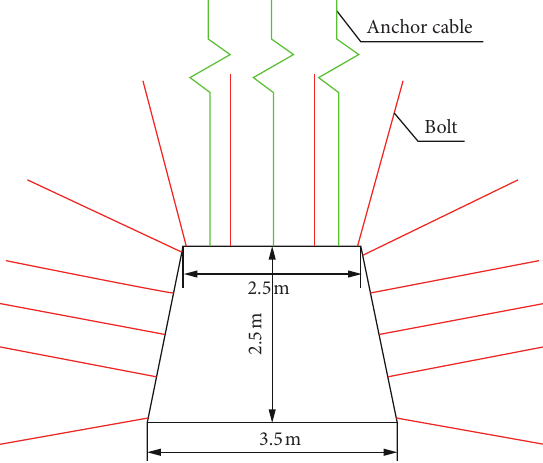
Figure 3: Original support scheme for a coal roadway. Table 1: Coal seam roof and floor